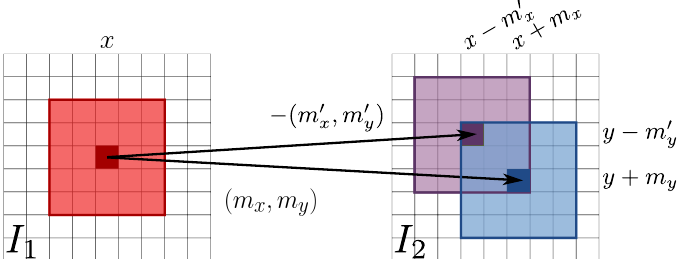
Figure 3. Illustration of the I 2 → 1 image formation process from the two resynthesized images ˜ I ( x , y ) and ˜ I (cid:48) ( x , y ) , respectively driven by the optical flow estimation maps ( m x , m y ) and 2 → 1 2 → 1 (cid:48) − ( m (cid:48) ) . A point ( x , y ) in I 1 can be mapped back to I 2 according to either Equation (1) or x , m y Equation (2). The best back-mapping minimizing locally the error among the two possible opti- cal flow estimates is then chosen to form I 2 → 1 . Best viewed in